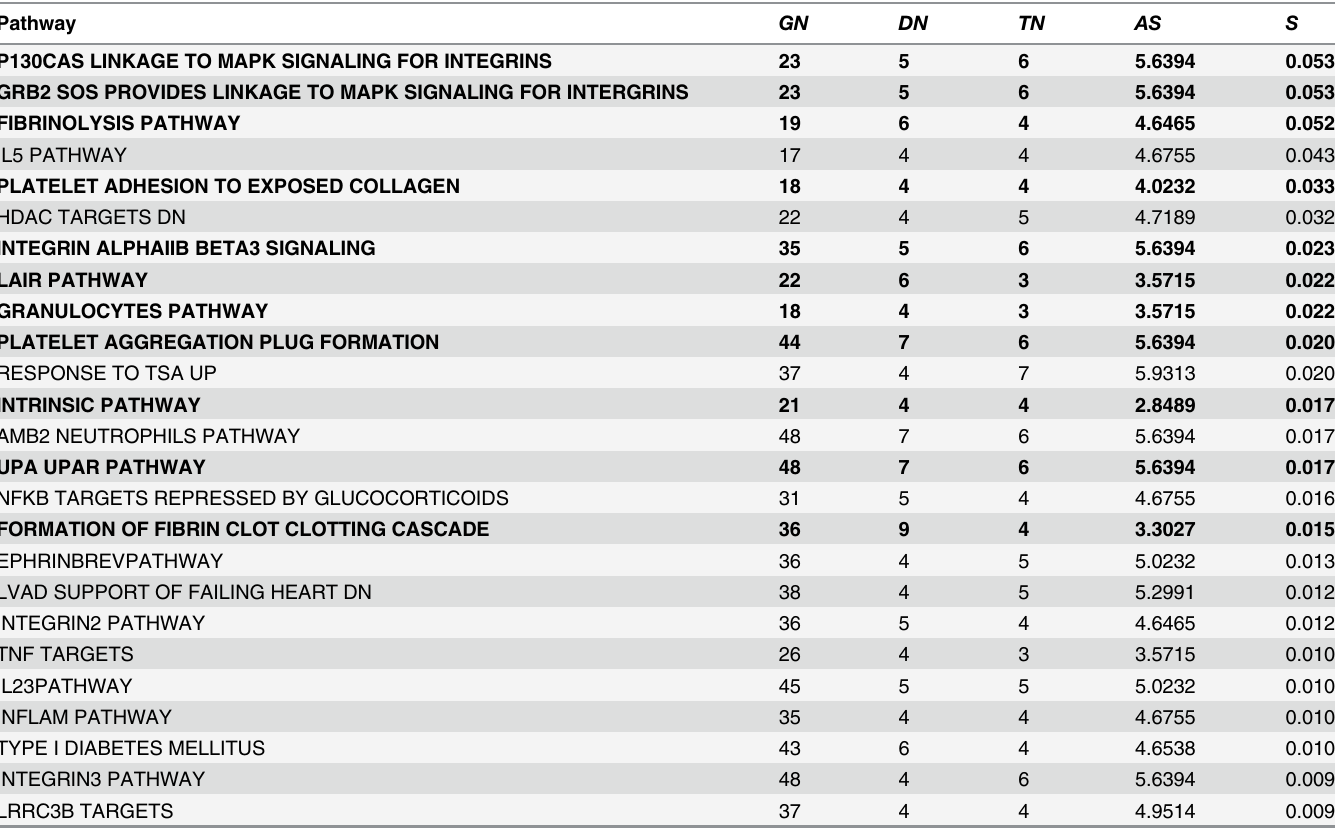
Table 3. Pathways whose sub-network score s is higher than 0.0098, where GN represents sub-network gene number, DN and TN represent dis- ease gene number and target gene number on the sub-network, respectively.